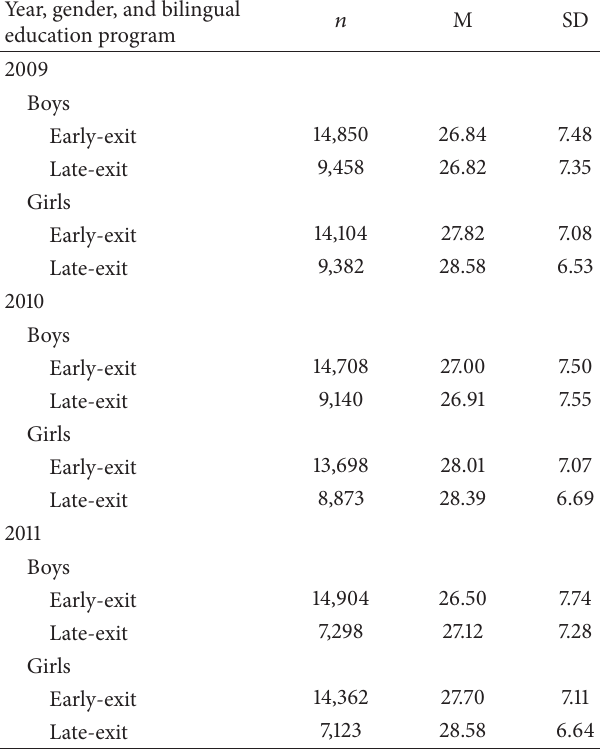
Table 1: Descriptive statistics for the 2009, 2010, and 2011 TAKS Reading scores for Grade 3 boys and girls by bilingual education